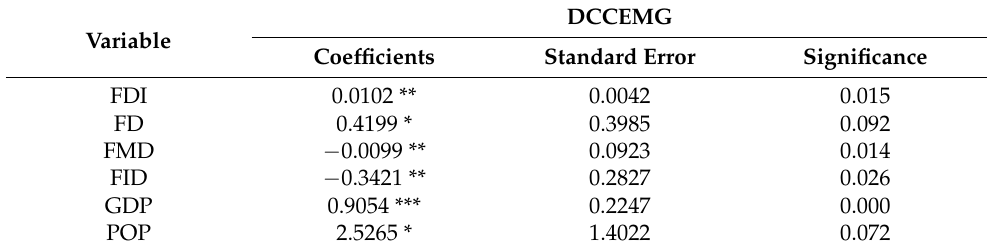
Table 8. Outcomes of the DCCEMG